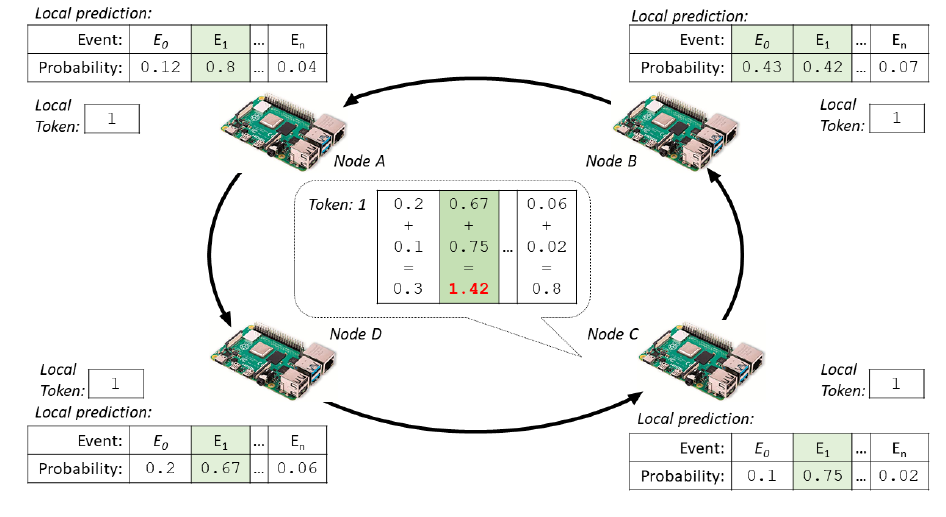
Figure 7. Logical organization of